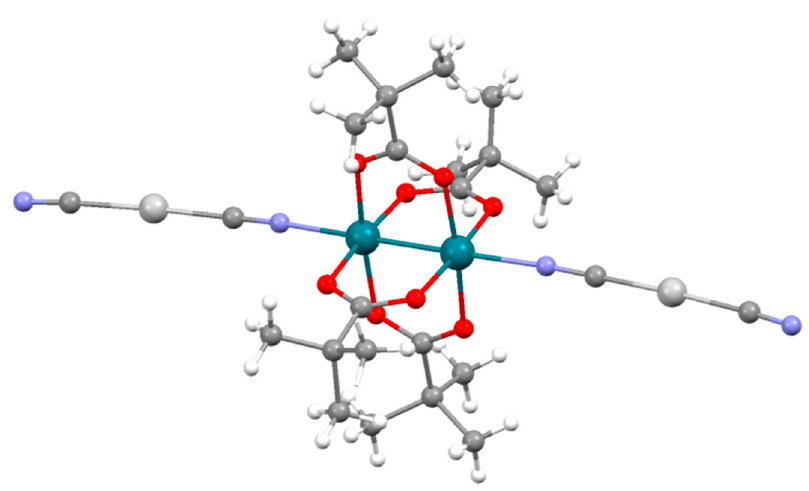
Figure 6. View of the {Rh 2 ( μ -O 2 CCMe 3 ) 4 [Ag(CN) 2 ] 2 } 2 − units that form 6 .